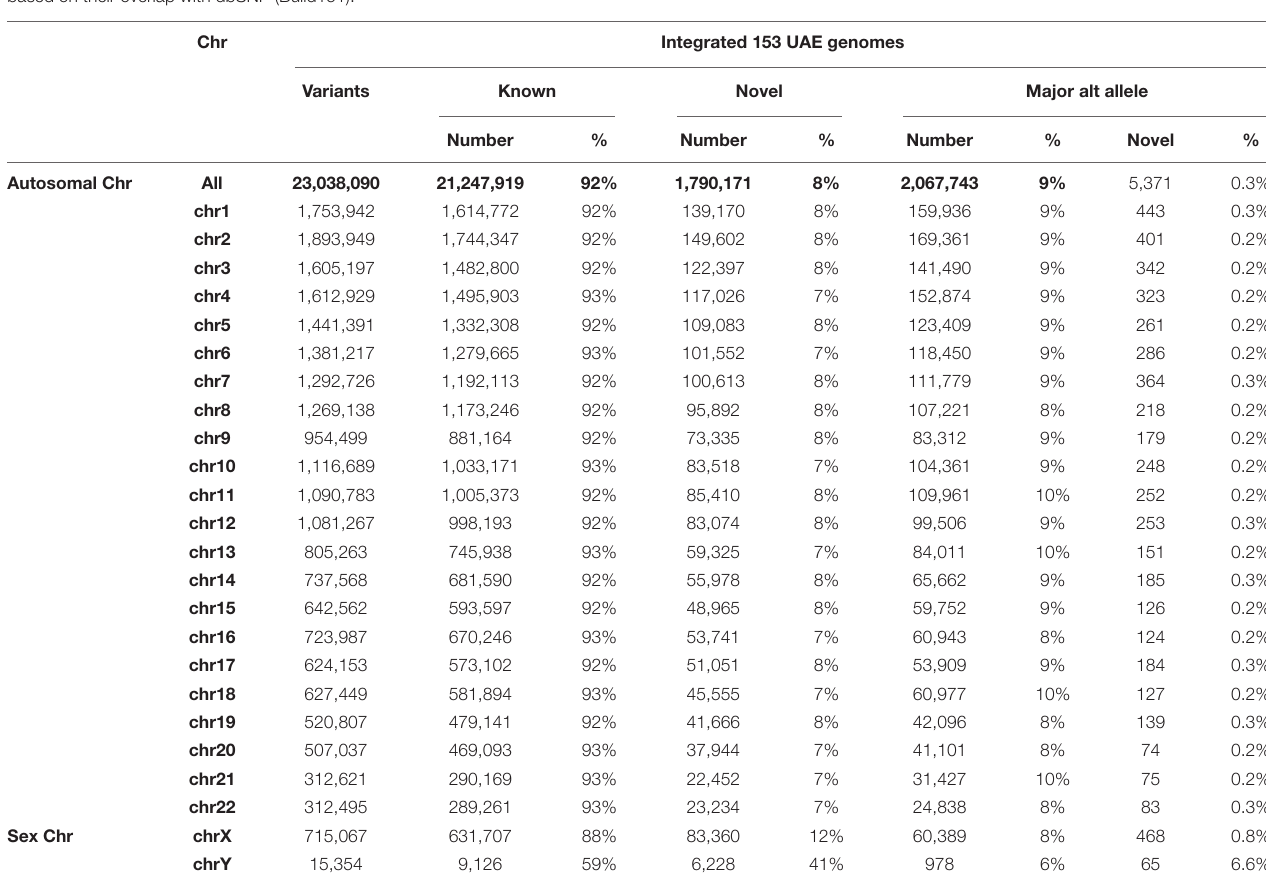
TABLE 2 | The summary of autosomal and sex chromosomes’ variants called by genotyping of the 153 UAE nationals showing the known and novel number of variants based on their overlap with dbSNP